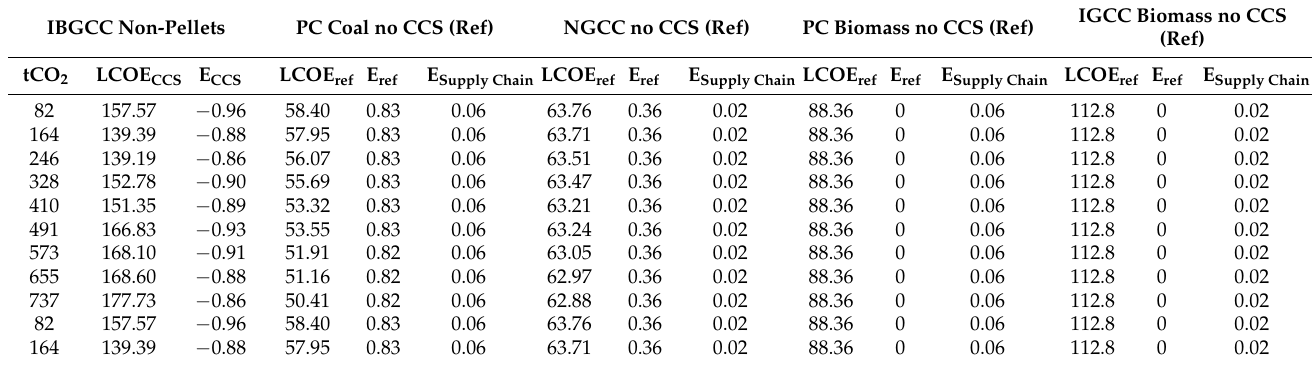
Table A5. Levelized Cost of Electricity (LCOE, in $/MWh) and Emissions Intensity (E, in tCO 2 /MWh) for the four CAC reference cases and IBGCC non-pelletized